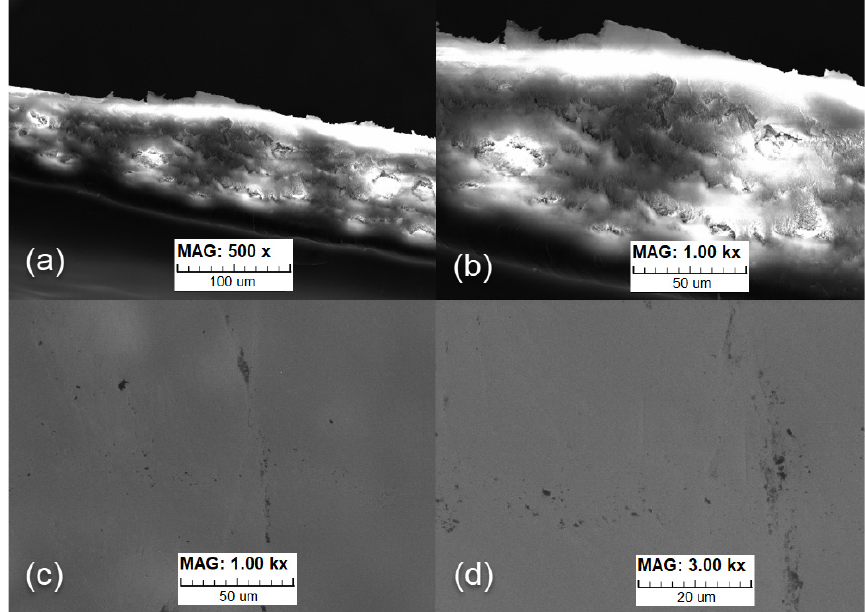
Figure 3. Images of composite PE/PUR membrane ( a , b ) cross-section and ( c , d ) surface under 500×, 1000×, and 3000× magnifications.